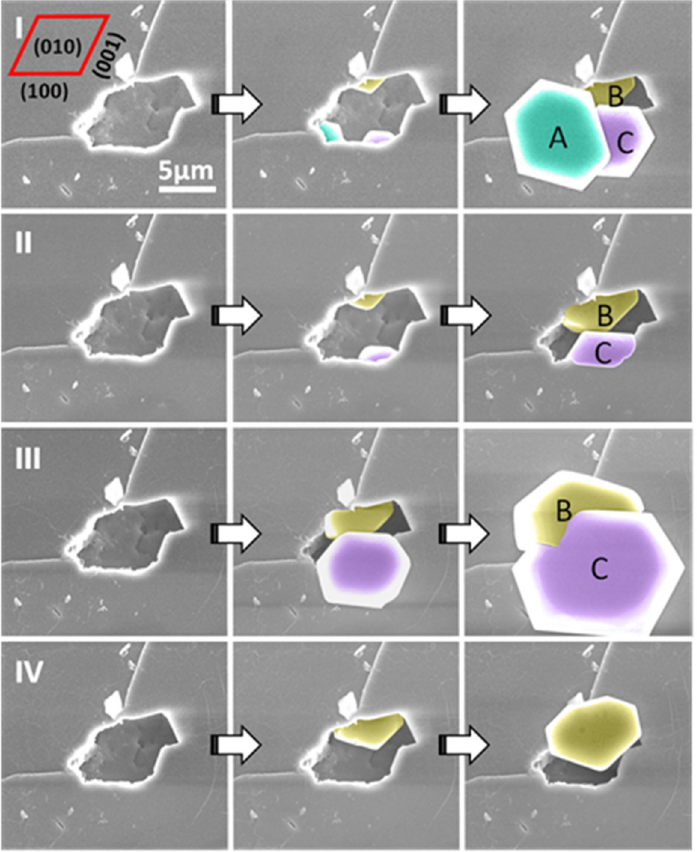
Figure 6 . ESEM images of four nucleation cycles ( I – IV ) from a single pore on the (010) face of the feldspar crystal. The crystal grown from the exact site inside the pore always shows the same orien- tation; however, crystals grown from different sites inside the pore can show different orientations: A, B and C show slightly different orientations, but B and C, which appear in cycles ( I – III ), always show the same orientation. Figure adapted with permission from [72]. Copyright 2019 American Chemical Society.